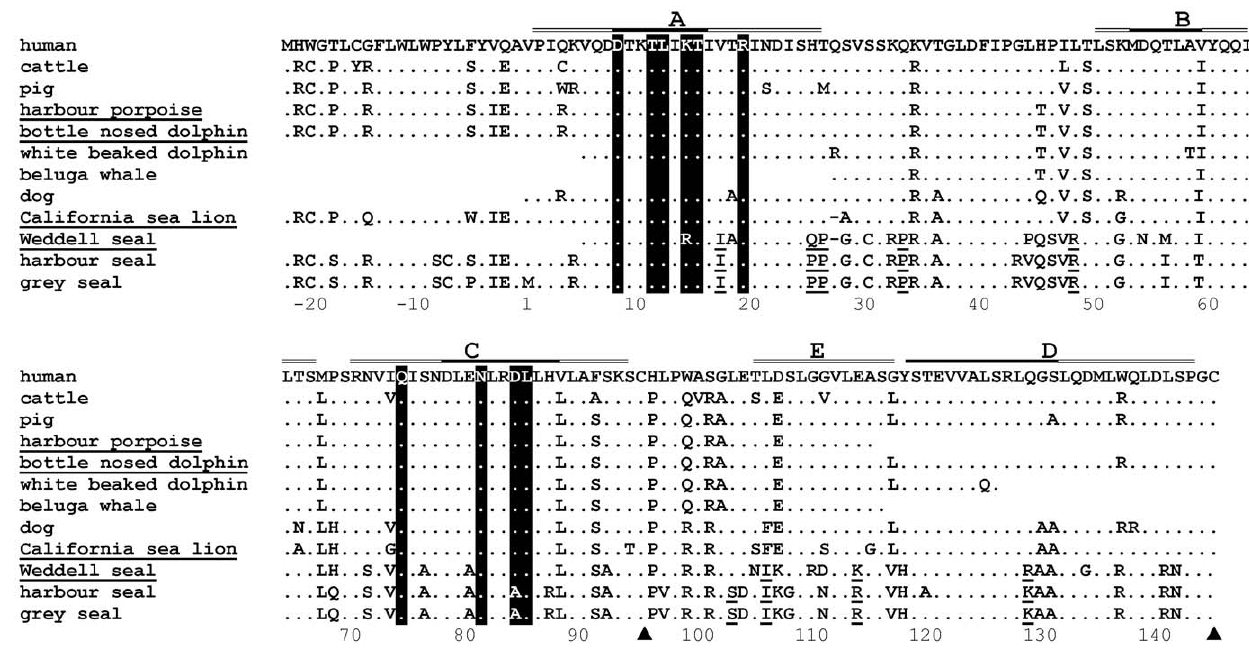
Figure 1. Leptin LEPR-binding residues are conserved across diverse mammalian phyla including the marine mammals. Summary representative alignment of the predicted amino acid sequences of selected mammalian leptin molecules. Identical residues to human leptin are marked with a dot, spaces manually introduced into the alignment are indicated by ‘-’. Shading represents the leptin residues critical for LEPR binding [24,25], underlined residues show evidence of positive selection within representatives of the Family Phocidae. The cysteine residues critical for folding are indicated by m . The residues that form the helices in the human leptin are marked with a track above the alignment, with the most conserved regions filled. Species for which leptin sequences are reported in this study are underlined. Residue numbering is based on the mature protein from human, residues with a negative placement occur within the signal sequence of the nascent peptide.